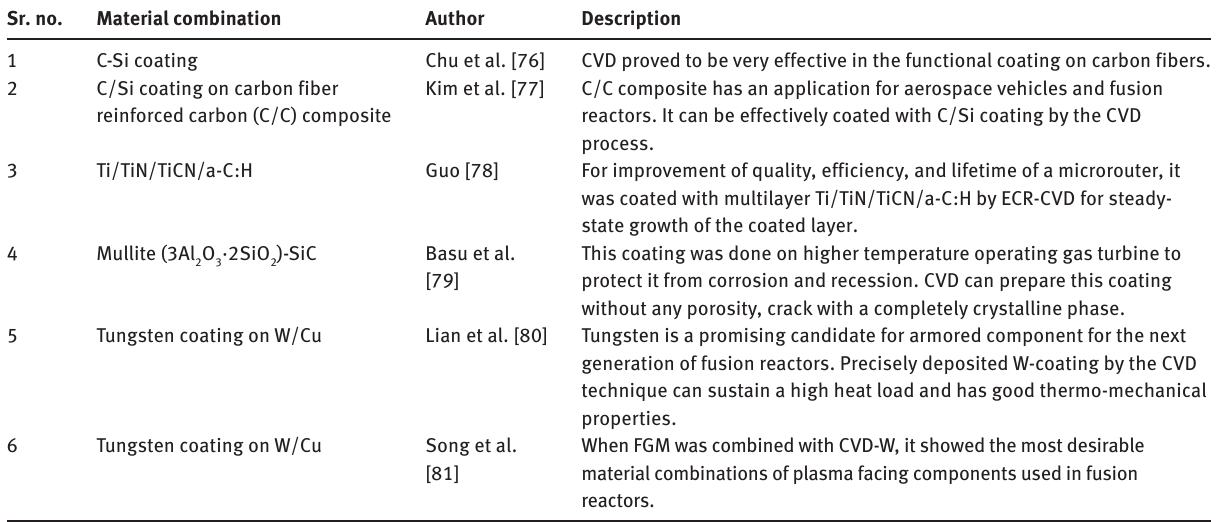
Table 6: List of different authors who used CVD for fabrication of FGM. Sr.